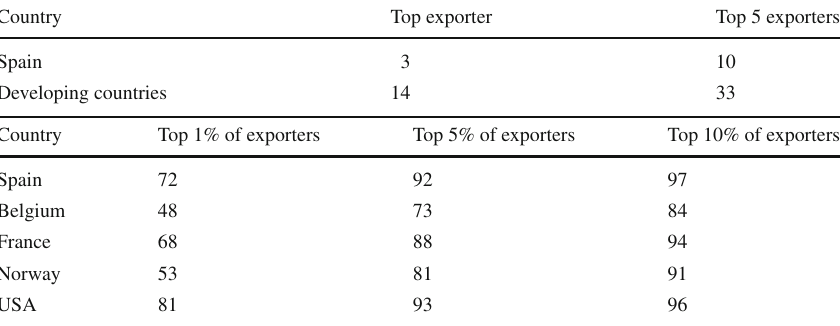
Table 3 Concentration of exports by firm in different countries (% of total exports). Source: Spain’s data come from authors’ own calculations, based on the Customs database and correspond to 2015. The data for developing countries come from Freund and Pierola (2015) and are calculated for the 2004–2008 period. Belgium, France and Norway’s data come from Mayer and Ottaviano (2008) and are for 2003. US data